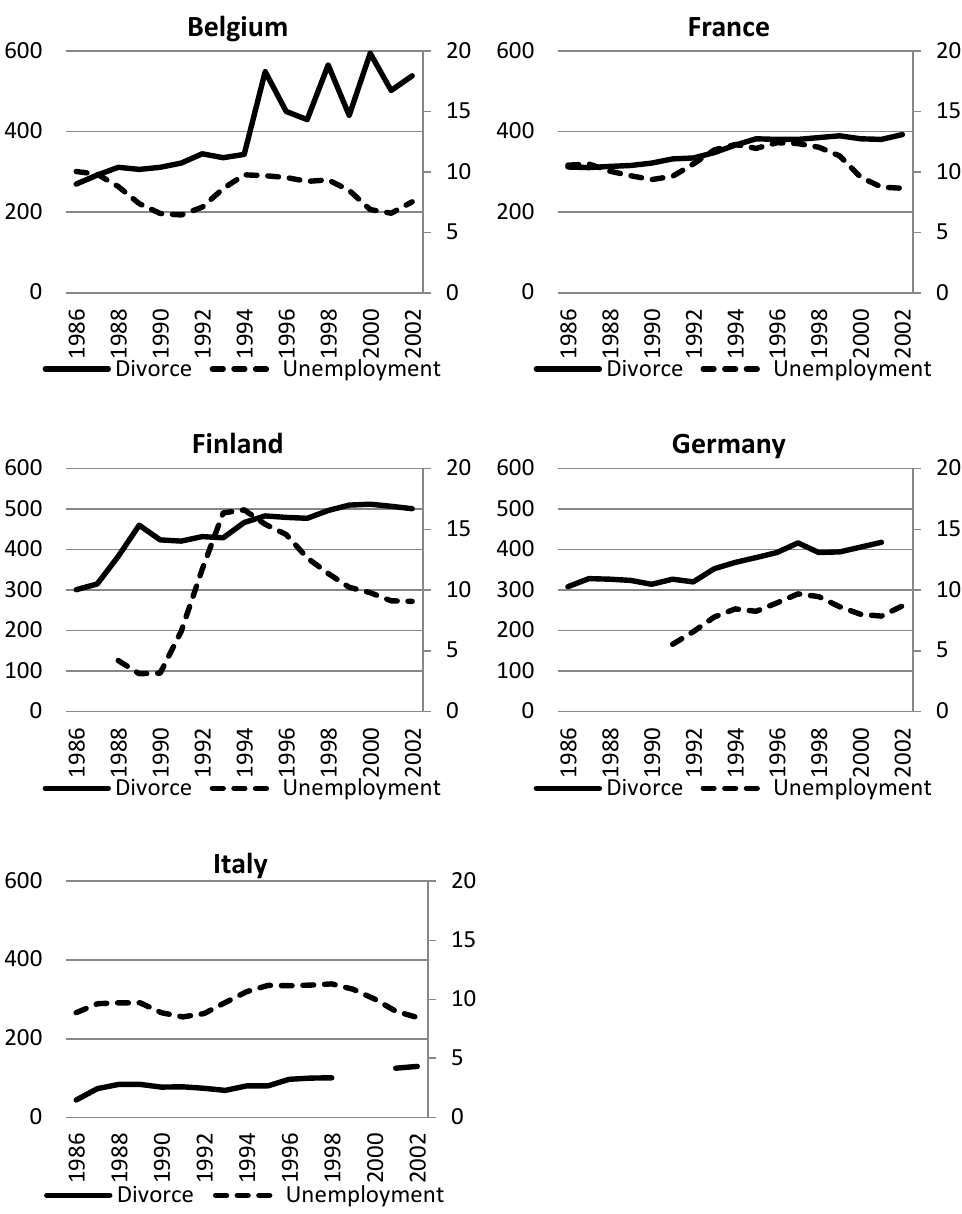
Sources : Yearly unemployment rate (OECD database Labour Force statistics, http://stats.oecd.org/), Divorce